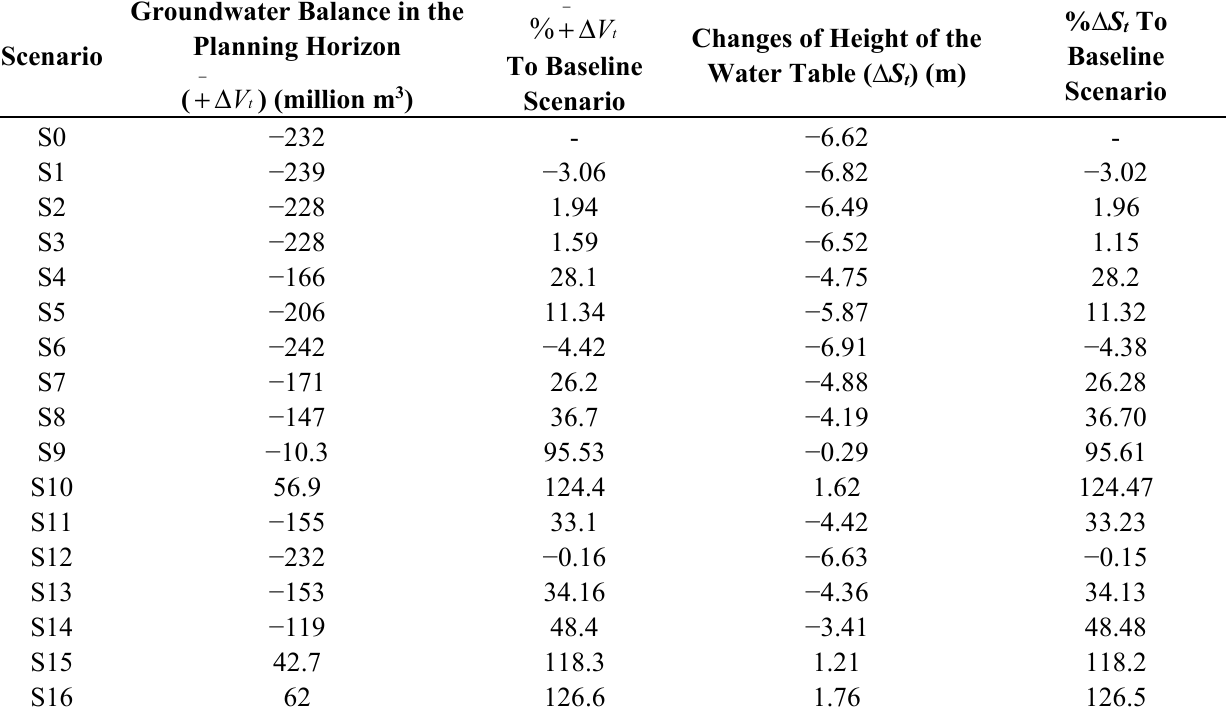
Table 2. Groundwater volume fluctuations under different economic scenarios in the Dry climate condition on the planning